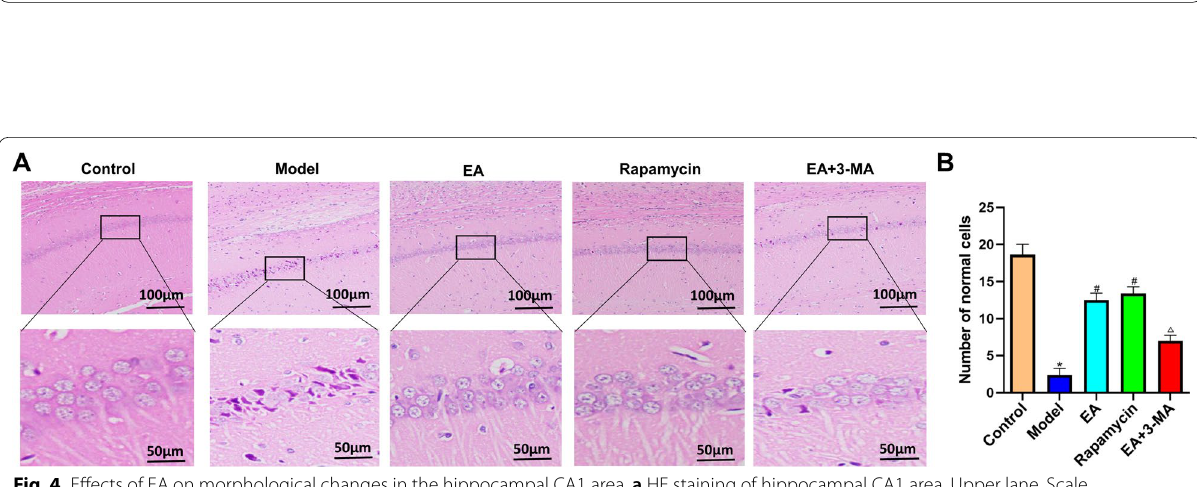
50 μm, magnification 400). The pyramidal neurons = × 3-MA groups, +